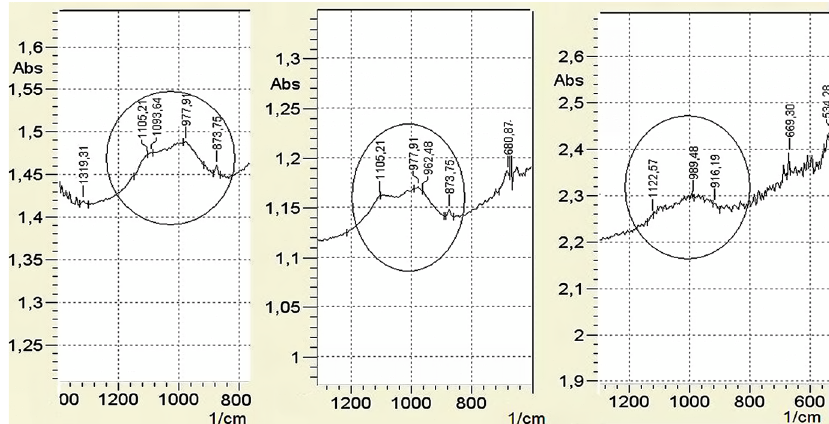
Fig. 2. IR spectrum of suspensions being treated for 4, 6, 8 hours in the considered interval (from left to right)